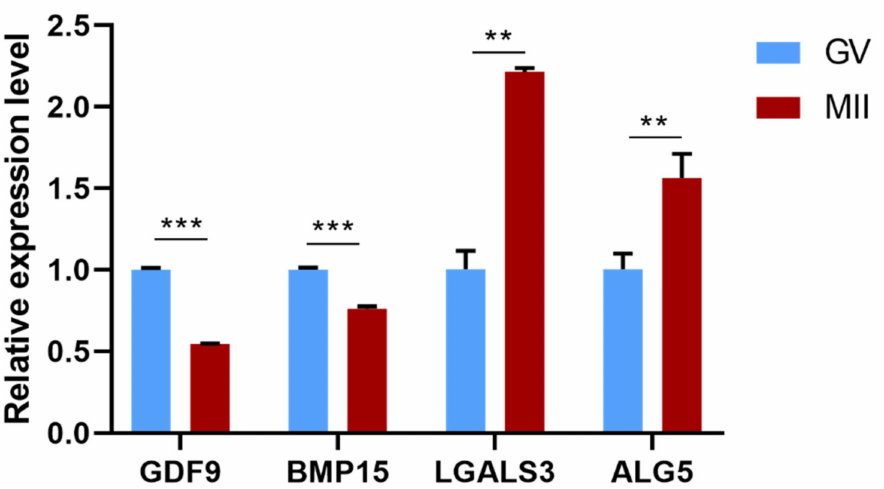
Figure 6. The expression of differentially expressed genes during oocyte maturation. ** indicates p < 0.01; and *** indicates p <